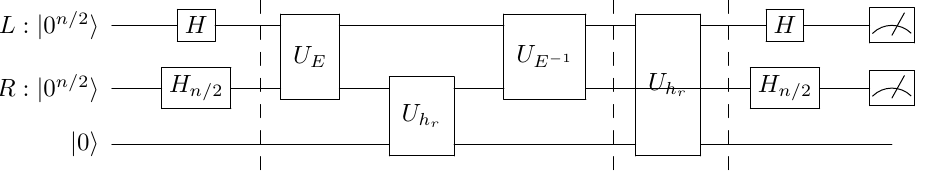
Figure 9: Quantum circuit Q HS for a Hashed-Simon -distinguisher on 3-round Feistel. Notice that the second hash function in Figure 9 hashes the first n/ 2 qubits to